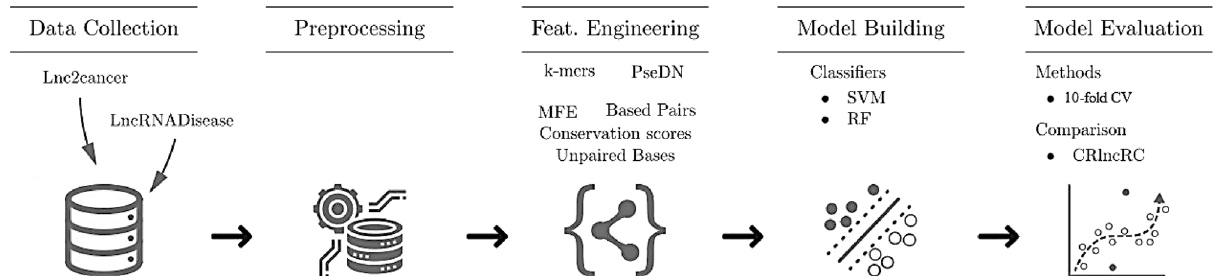
Figure 1. Workflow of